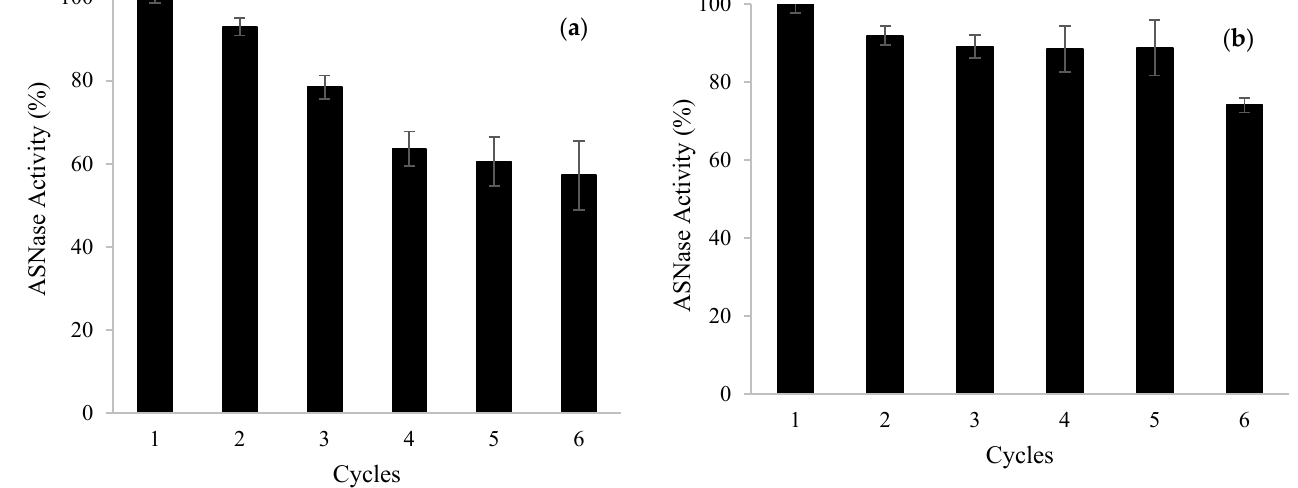
Figure 6. Operational stability of immobilized L-asparaginase (ASNase) onto ( a ) pristine and ( b ) functionalized multi-walled carbon nanotubes (f-MWCNTs-1020). Error bars correspond to the standard deviation between replicates.